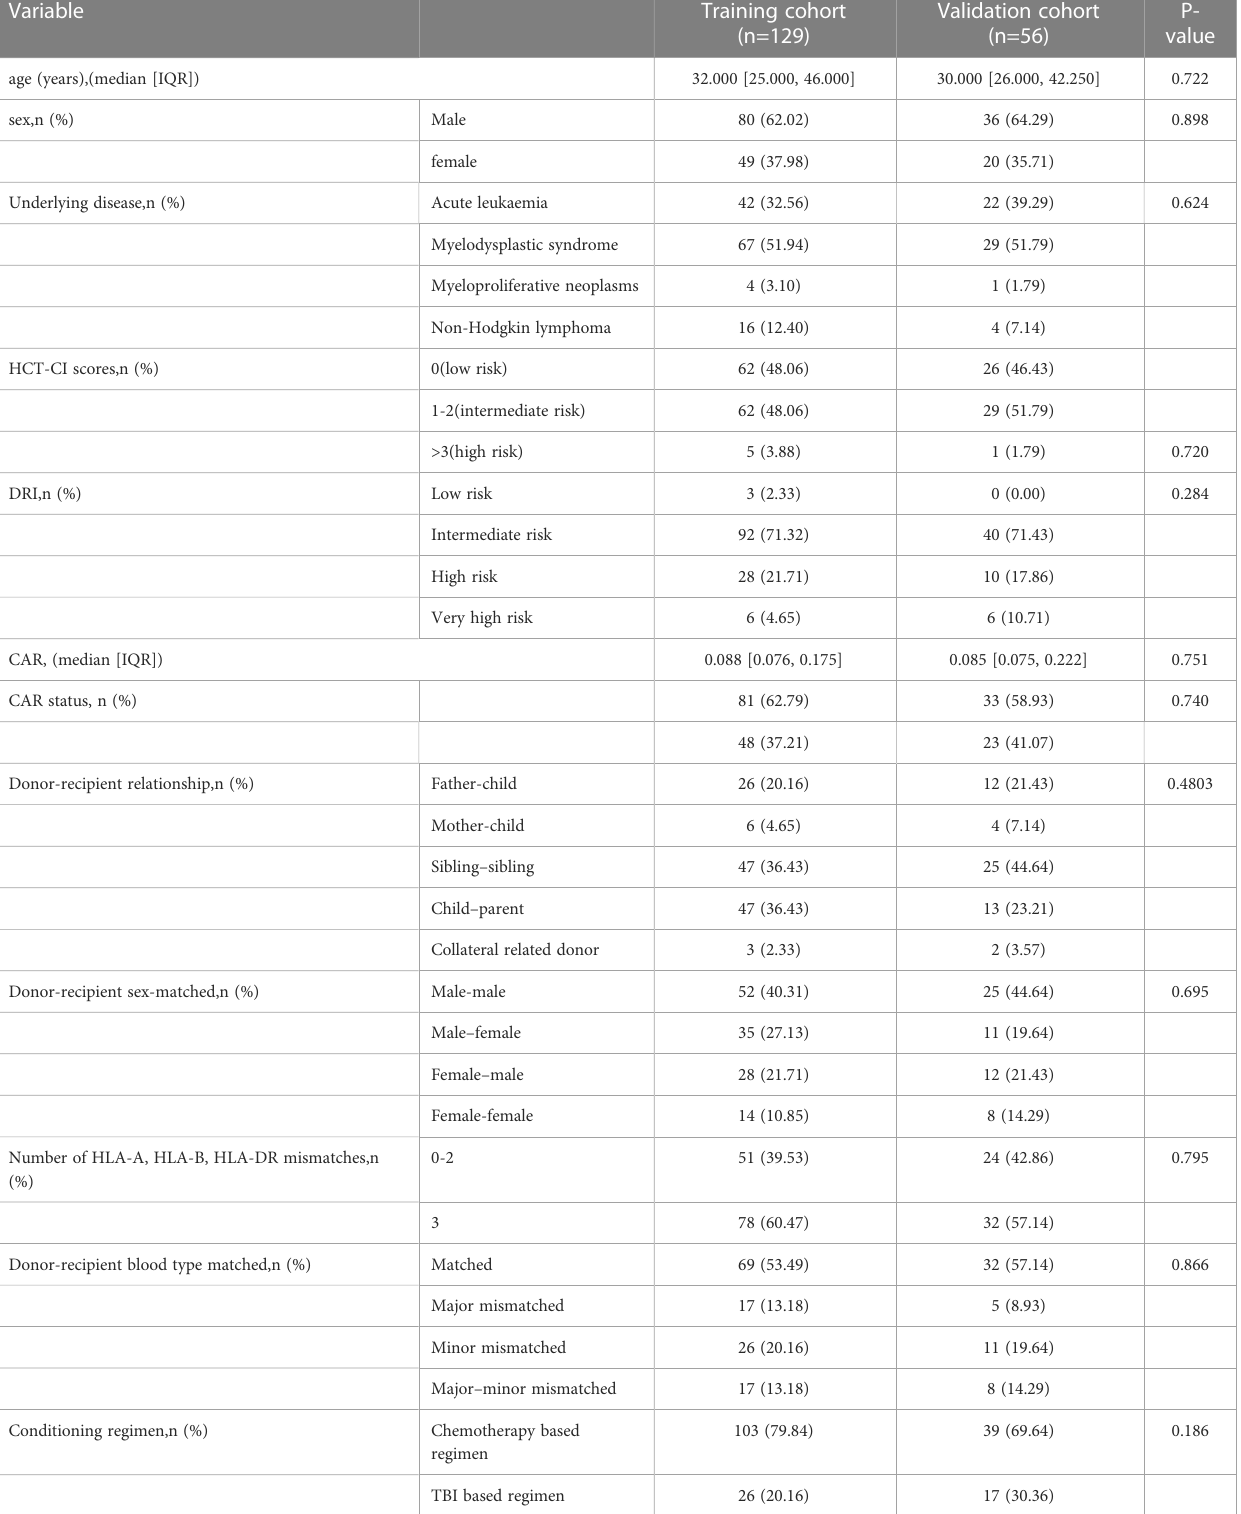
TABLE 2 Patients ’ baseline